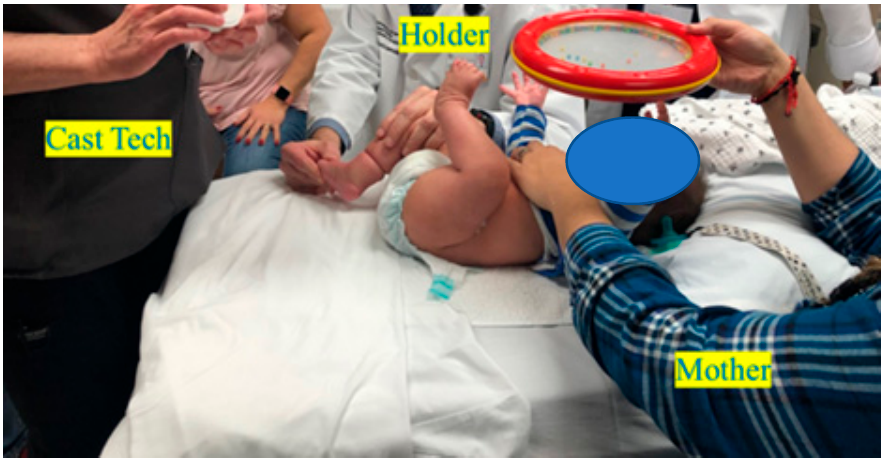
Figure 1. Correct set up for the Ponseti serial casting